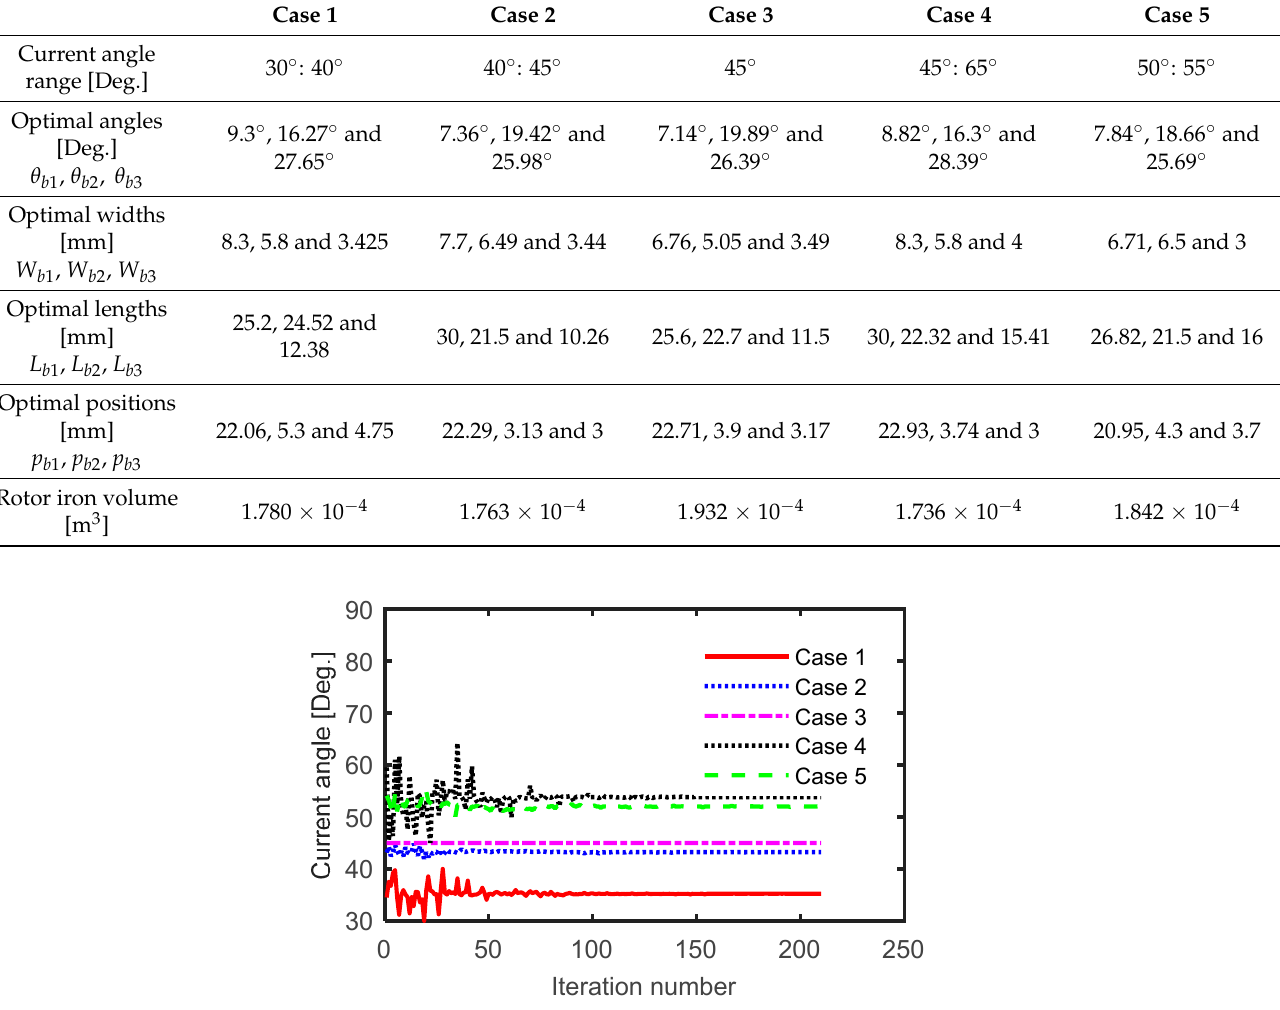
Table 4. Final optimal geometry for the SynRM for different case studies.